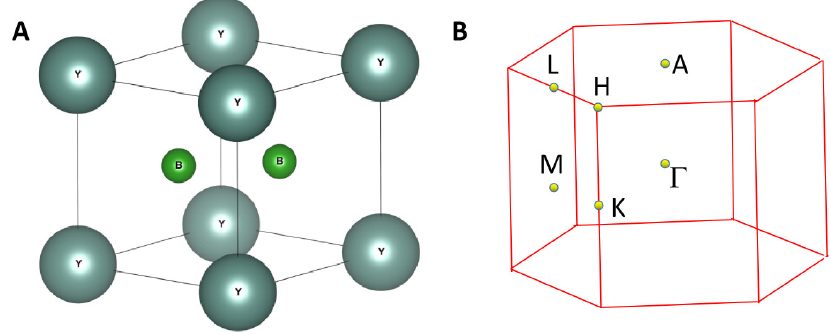
Figure 1. ( A ) Structural model of P6/mmm YB 2 , ( B ) the bulk Brillouin zone (BZ) of YB 2